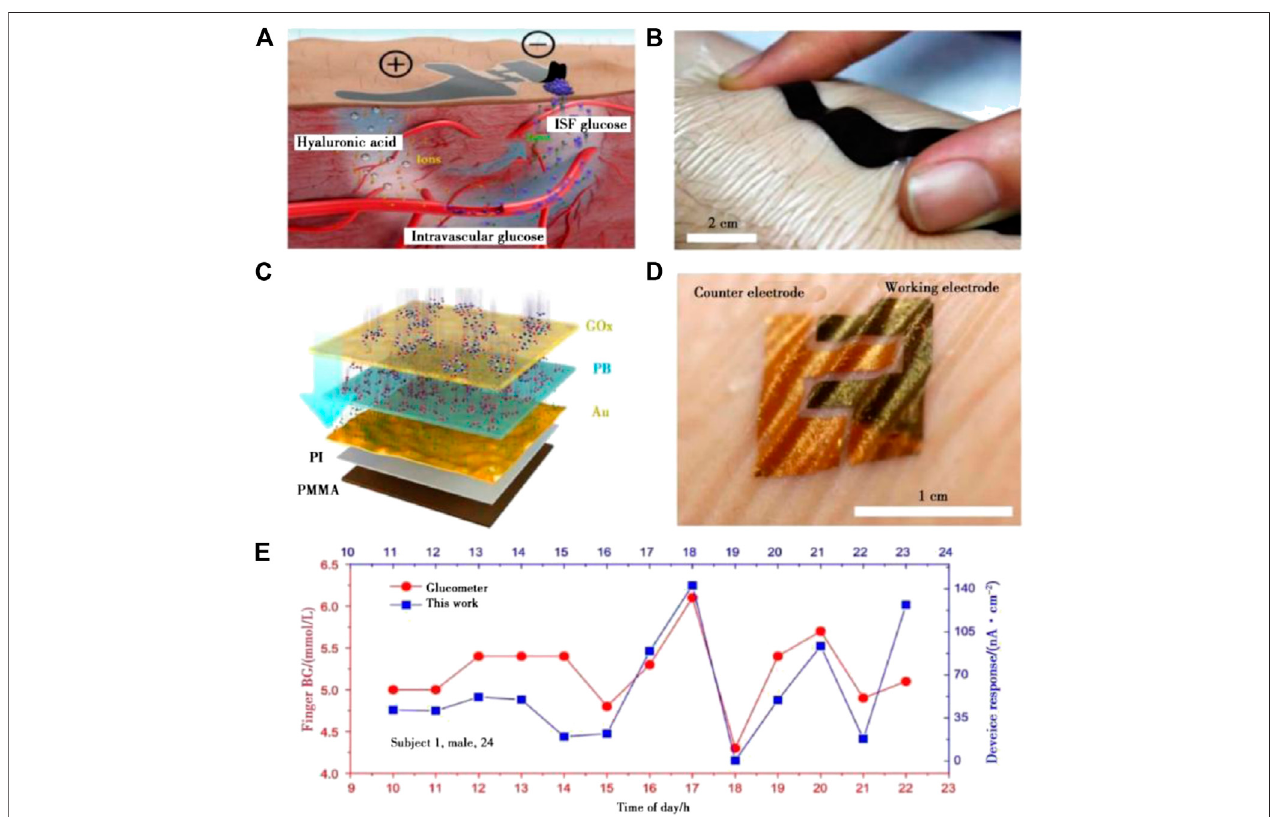
FIGURE 10 | (A) Scheme of the ETCs; (B) the paper battery attached to the skin surface; (C) scheme of the skin-like biosensor multilayers; (D) the biosensor completely conforms to the skin surface; (E) results of hourly glucose monitoring in 1-day period by using a glucometer (red) and skin-like biosensor (blue) (Chen et al., 2017). Reproduced with